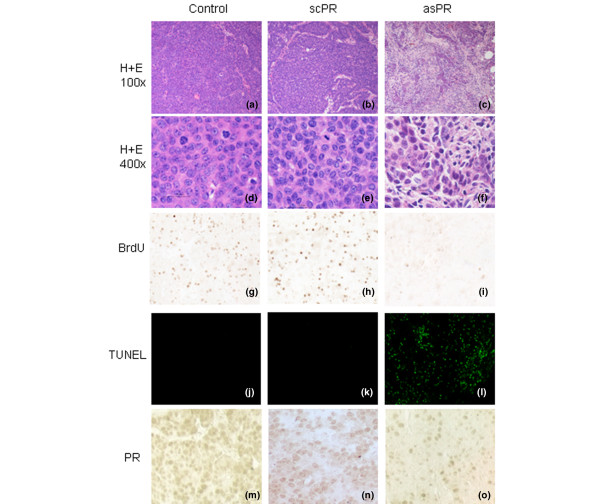
Morphological features and PR immunostaining in tumors treated with asPR or scPR for 5 days. Left column: control mice treated with saline; middle column: mice treated with scPR; right column: mice treated with asPR. (a–c) Hematoxylin and eosin (100×); (d-f) Hematoxylin and eosin (400×); (g–i) 5-BrdU immunocytochemistry; (j–l) TUNEL (100×); (m-o) PR immunohystochemistry. No changes were observed in tumors from animals treated with saline or scPR. Tumors from animals treated with asPR exhibit increasing degrees of fibrosis, as well as occasional lymphocytic infiltration. TUNEL staining, indicative of apoptosis, was only observed in asPR-treated tumors (panel i), in which also very few 5-BrdU stained nuclei were observed (panel f). Few PR stained nuclei are observed in asPR-treated tumors (panel l) as compared with control or scPR-treated tumors, in which most of the cells are positive (panels j and k, respectively). asPR, antisense oligodeoxynucleotides to progesterone receptors; PR, progesterone receptor; scPR, scrambled oligodeoxynucleotides to progesterone receptors; TUNEL, terminal deoxynucleotidyl transferase mediated dUTP nick-end labeling.